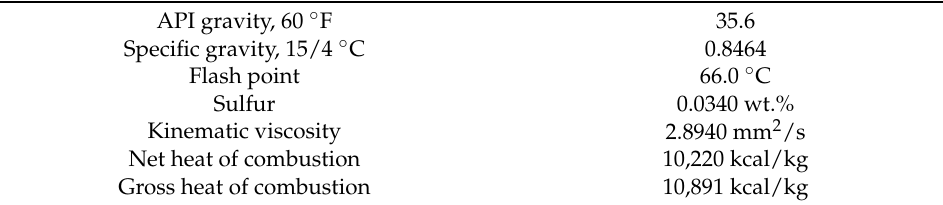
Figure 3. Flowchart for emission prediction modeling. Table 4. Fuel specifications.